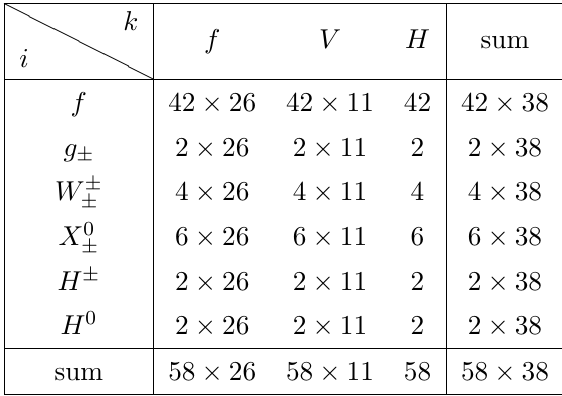
, required in our high scale evolution. Here i labels the states Table 1 . Total number of FFs, d k i required at the high scale Q ∼ m . As we work in the full unbroken standard model, i can χ take 58 values: 42 fermions ( 2 × 3 × { e for particle/antiparticle and three L , e R , ν L , u L , u R , d L , d R } generations), 2 gluons (helicities), 4 charged electroweak bosons (two helicities and two charges), 6 neutral electroweak bosons (two helicities for each of B , W 3 , and the mixture, collectively labeled X 0 ), and the four degrees of freedom of the SU(2) L Higgs doublet. For k at the weak scale, the counting is similar although slightly rearranged. We now have 38 states as we only distinguish the helicity of the electroweak states (as this information is used in the weak matching), so we now have 26 fermions ( 2 × 3 × { e, ν, d } + 2 × { u, c } + 2 × { t ), 11 vectors ( { g, γ } + 3 × { W ± , Z } L , t R } including the three polarizations of the massive bosons), and 1 physical Higgs. Thus, in general 58 × 38 = 2204 FFs are